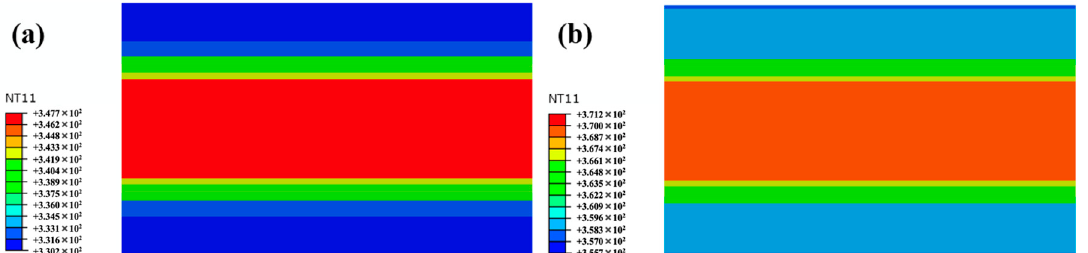
Figure 11. Temperature gradient in the thickness of the laminate at Point A under ( a ) hot pressing and ( b ) autoclave at 18,000 s.